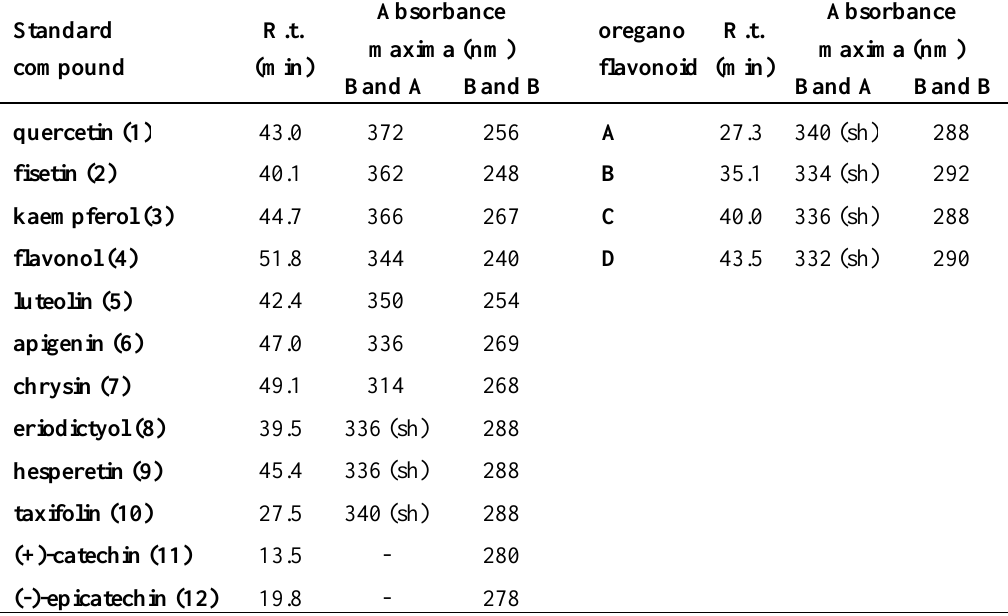
Table 1. The retention times as well as the spectral characteristics (UV) of the standards and the isolated flavonoids from